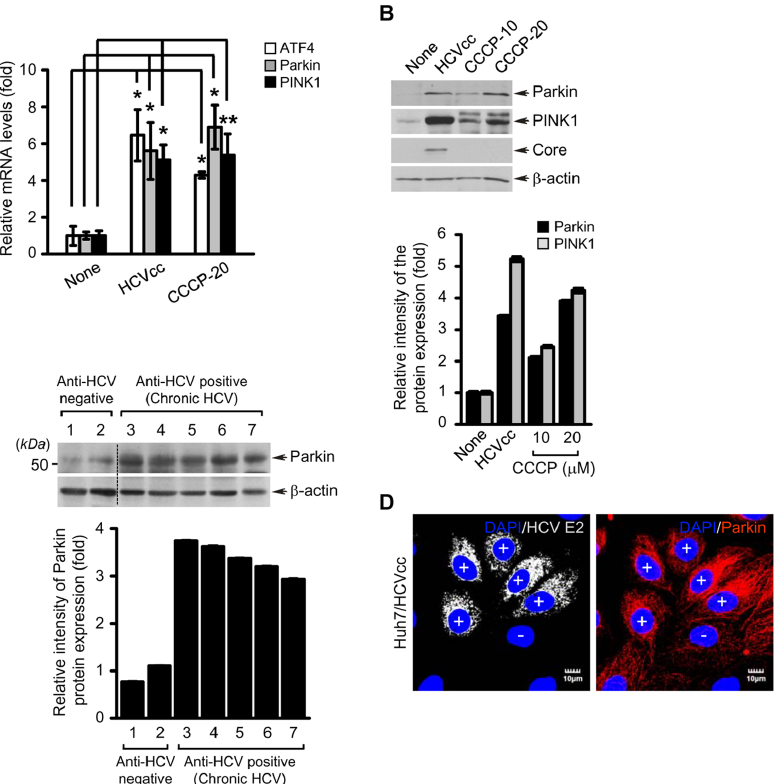
Figure 3. HCV infection stimulates ATF4, Parkin, and PINK1 gene expression. ( A and B ) Quantitative analyses of ATF4, Parkin, and PINK1 gene expression in HCV-infected cells. Huh7 cells infected with HCVcc for 5 days or treated with CCCP (10 or 20 m M) for 24 h were used for analysis of ATF4, Parkin, and PINK1 gene expression. ( A ) Intracellular mRNA levels of ATF4, Parkin, and PINK1 were analyzed by real-time qRT-PCR. GAPDH was used to normalize changes in Parkin and PINK1 gene expression (mean 6 SD; n=3; * p , 0.01, ** p , 0.05). P values were calculated by using an unpaired Student’s t-test. ( B ) The protein expression levels of Parkin and PINK1 were analyzed by immunoblotting with anti-Parkin and PINK1 antibodies. The expression of HCV core protein was analyzed by immunoblotting with anti-HCV core antibody. b -actin was used as an internal loading control. ( C ) Western blot analysis of Parkin expression in liver biopsies of chronic hepatitis C patients. Samples 1 and 2 represent liver biopsies of HCV-negative patients and samples 3–7 represent HCV-positive chronic hepatitis patients. ( B and C ) The relative intensity of Parkin and PINK1 expression normalized to b -actin analyzed by ImageJ. ( D ) Confocal microscopy showing Parkin overexpression in HCV-infected cells. Huh7 cells infected with HCVcc were immunostained with anti-Parkin antibody (red). Fluorescence image of HCV E2 verifies HCV-infected cells (light gray). Nuclei were stained with DAPI (blue). Infected ( + ) and uninfected cells ( 2 ) are marked.